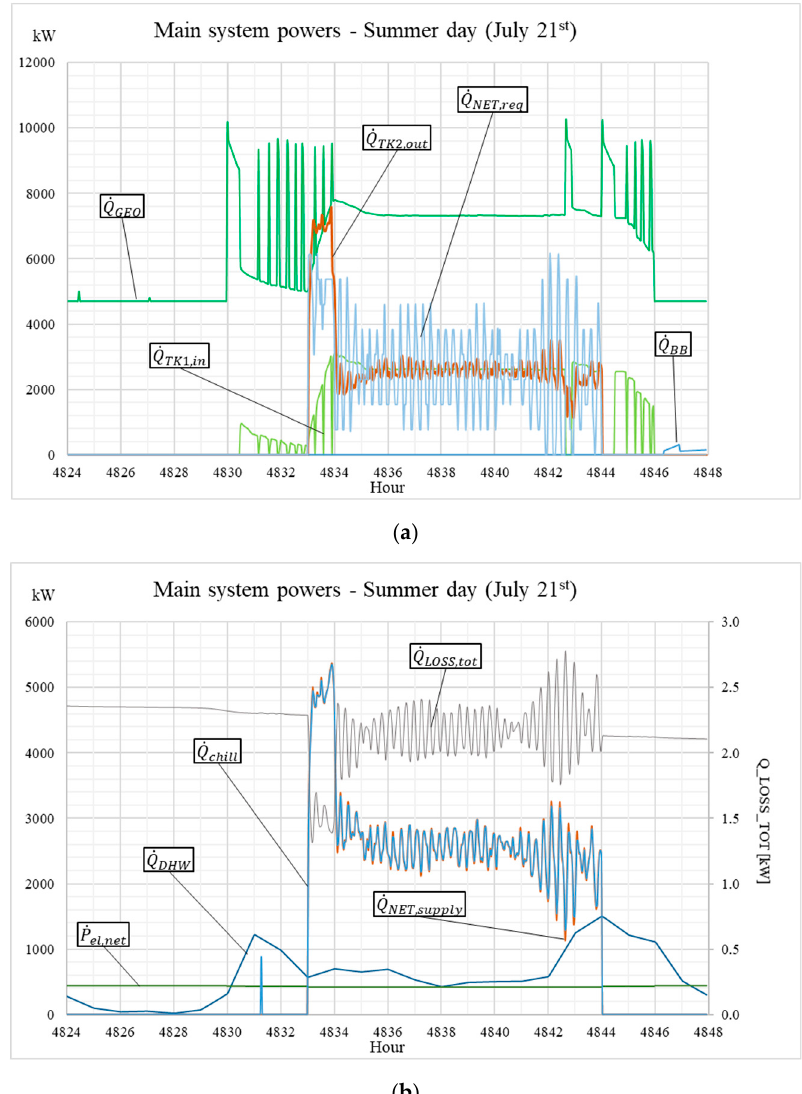
. . . . Q geo , Q NET.req, Q TK1,in, Q TK2,out and